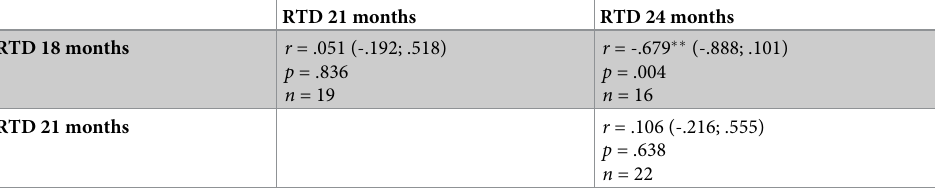
Table 3. Correlations between reaction time difference (RTD) scores at 18, 21 and 24 months of age in the longi- tudinal sample in Study 2 (95% confidence intervals in brackets, using bootstrapping with 1000